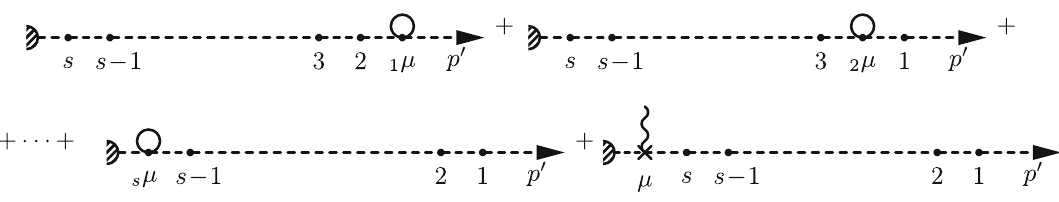
Fig. 5 The graphs in Figs. 2 and 3 can be combined into the s circled vertex graphs and an ( s + 1 ) th graph with the inserted μ vertex to the left of all the other s vertices on the p (cid:8) leg, as shown above